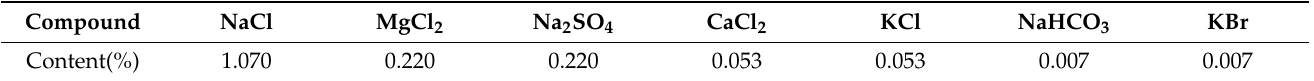
Table 3. Chemical composition of natural seawater.